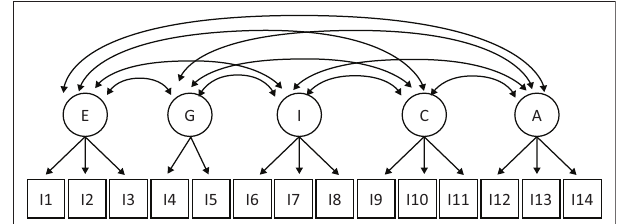
FIG URE 2: Correlated five-factor model for the innovative work